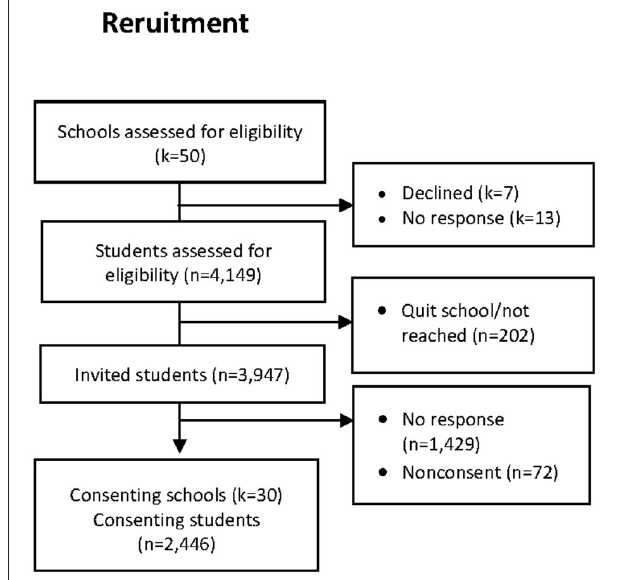
FIGURE 1 | Participant and school recruitment. k , number of schools; n , number of